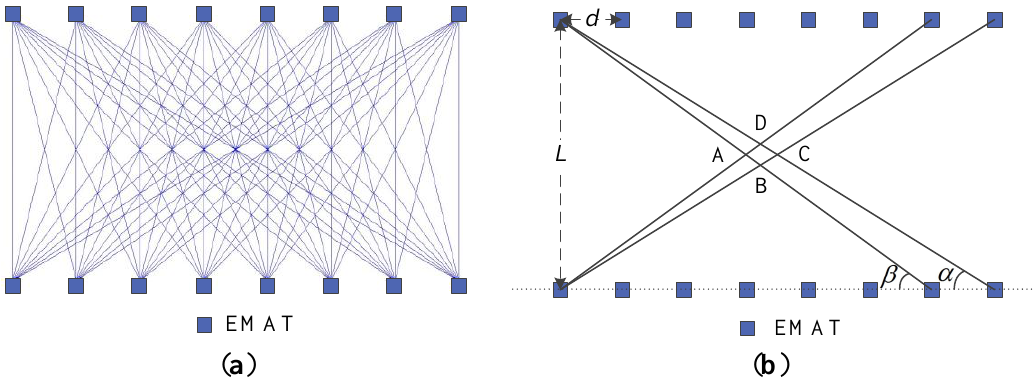
Figure 12. ( a ) The ULW ray trace pattern of the cross-hole method; ( b ) the schematic used for analyzing the relation between the resolution and the number of the EMATs for